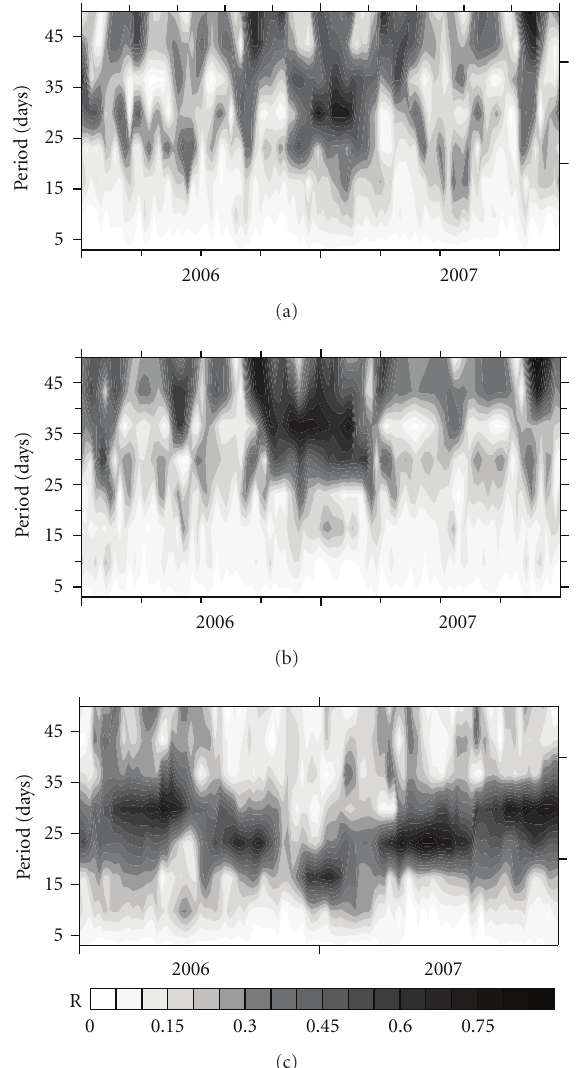
Figure 3: Periodogram spectra of stratospheric temperature (a), mesospheric temperature (b), Δ foF2 (c) in the period range of 5– 50 days. Statistical significance level corresponds to R ≥ 0 .